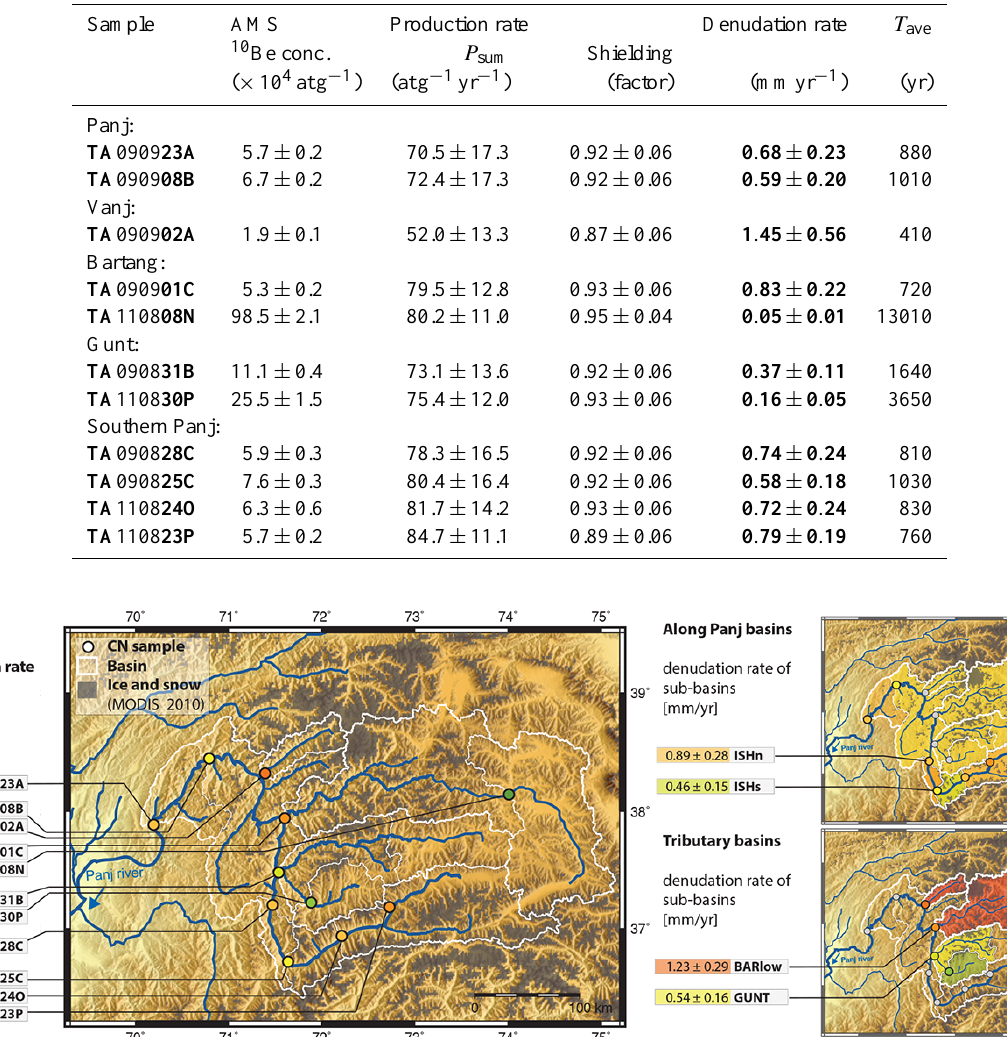
Table 2. Parameters and results of denudation rate calculation. AMS measurements were performed at DREAMS, Helmholtz-Zentrum Dresden-Rossendorf. The 10 Be concentrations are corrected for processing blanks ( 10 Be / 9 Be ratios of 2.0 × 10 − 15 and 2.1 × 10 − 15 , i.e. 0.3–1.7% of the sample values). The effective production rate represents the sum of the neutron- and muon-induced (fast and stopped muons) production of 10 Be in quartz ( P sum ), calculated using the scaling system of Stone (2000) and corrected for topographic shielding using the method of Codilean (2006). The values for individual basins are based on the arithmetic mean. T ave gives the average time needed to erode the typical attenuation depth of ∼ 60cm as a proxy of “cosmogenic memory”, describing the time over which the cosmogenic nuclide inventory averages. Bold letters in sample names indicate notations used in the text and figures.